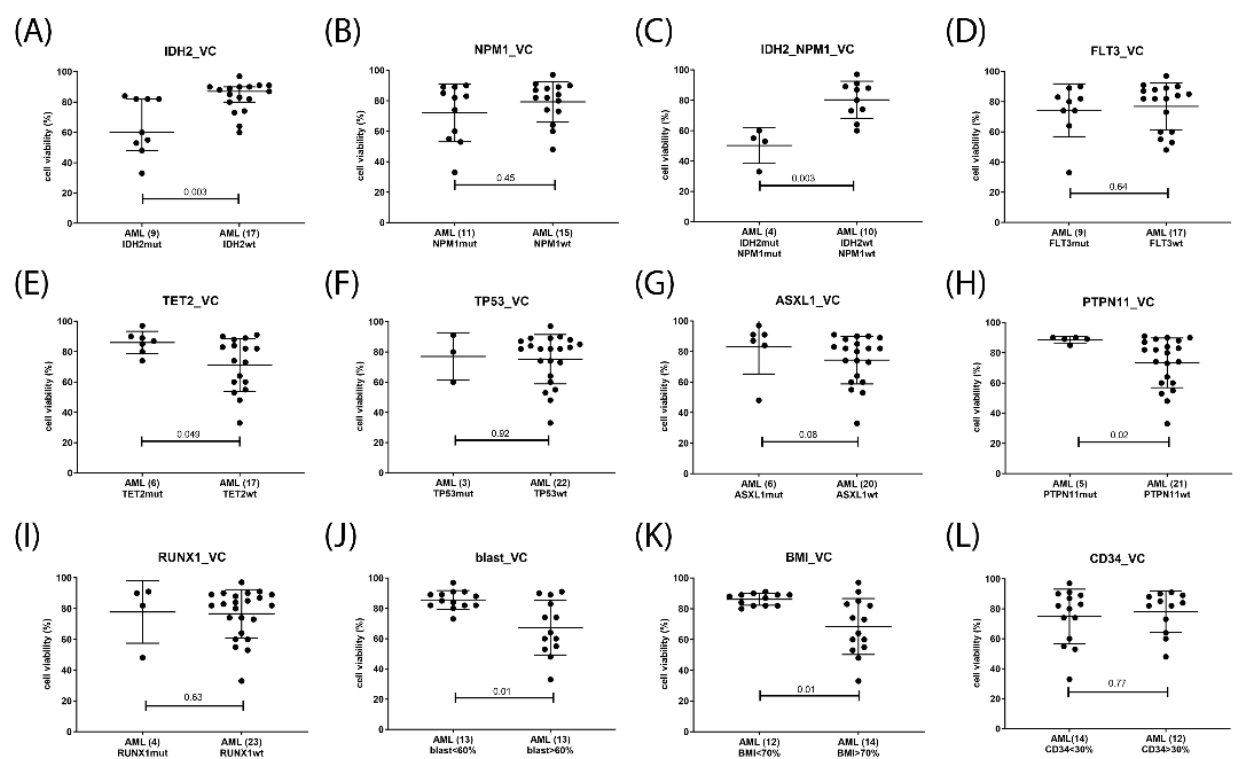
Figure 6. Response markers in venetoclax monotherapy. Cell viability was determined in mononu ‐ clear cells isolated from AML patients peripheral blood or bone marrow after 20 h treatment with 100 nM venetoclax. Hematological cells were grouped according to single gene mutation status of